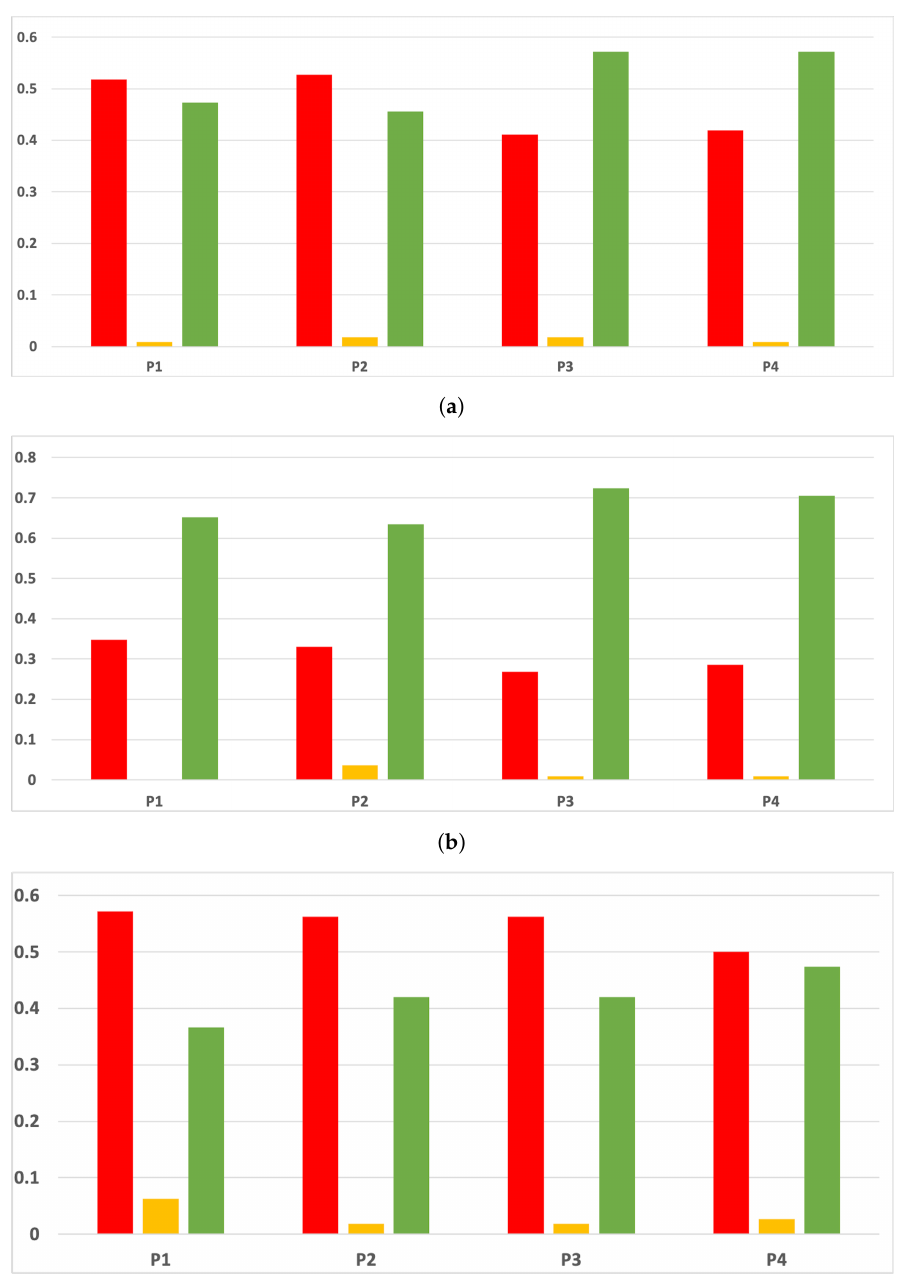
Figure 20. Experiment 2: consistency per partition (accuracy and time complexity). ( a ) Rate of validity per partition in RF. In axis X, the partition of the dataset. In axis Y, the rate of RHOASo for each class of validity. ( b ) Rate of validity per partition in GB. In axis X, the partition of the dataset. In axis Y, the rate of RHOASo for each class of validity. ( c ) Rate of validity per partition in MLP. In axis X, the partition of the dataset. In axis Y, the rate of RHOASo for each class of